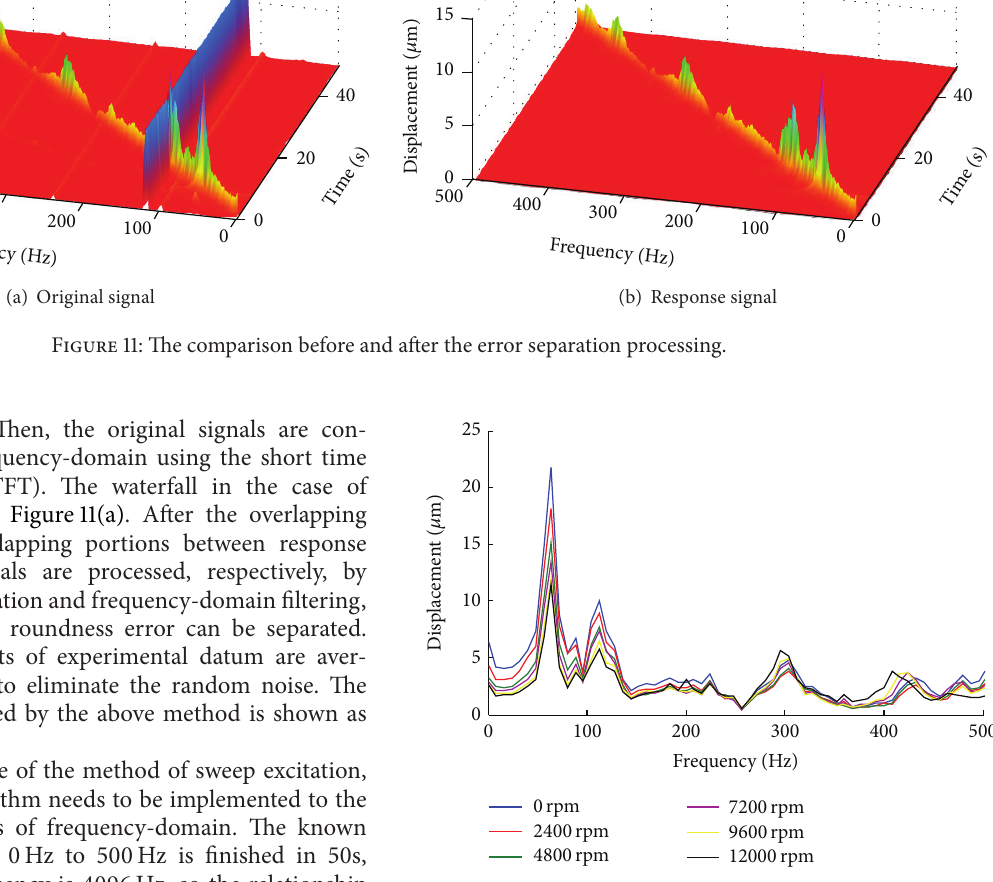
Figure 12: Relationship between displacement response and excit- ing frequency at different